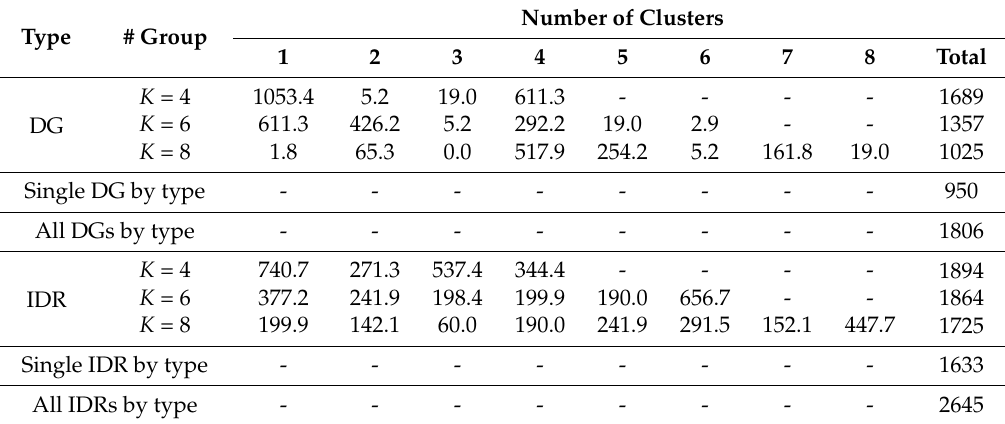
Table 3. Remuneration